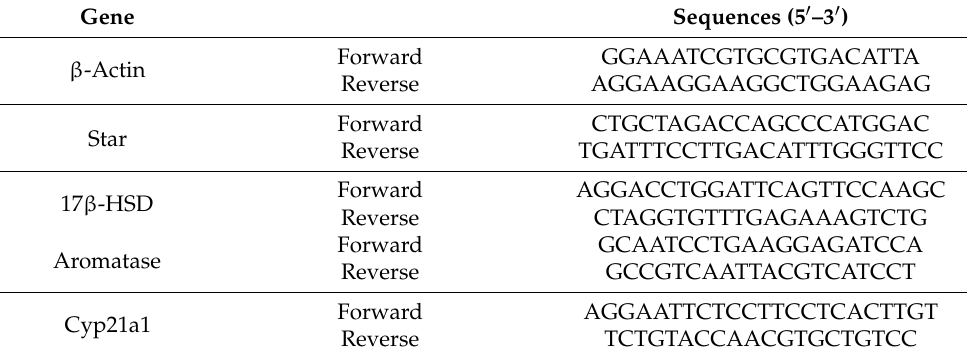
Table 1. Primers for PCR and Real-Time PCR Gene Sequences (5 (cid:48) –3 (cid:48) ). Gene Sequences (5 (cid:48) –3 (cid:48)